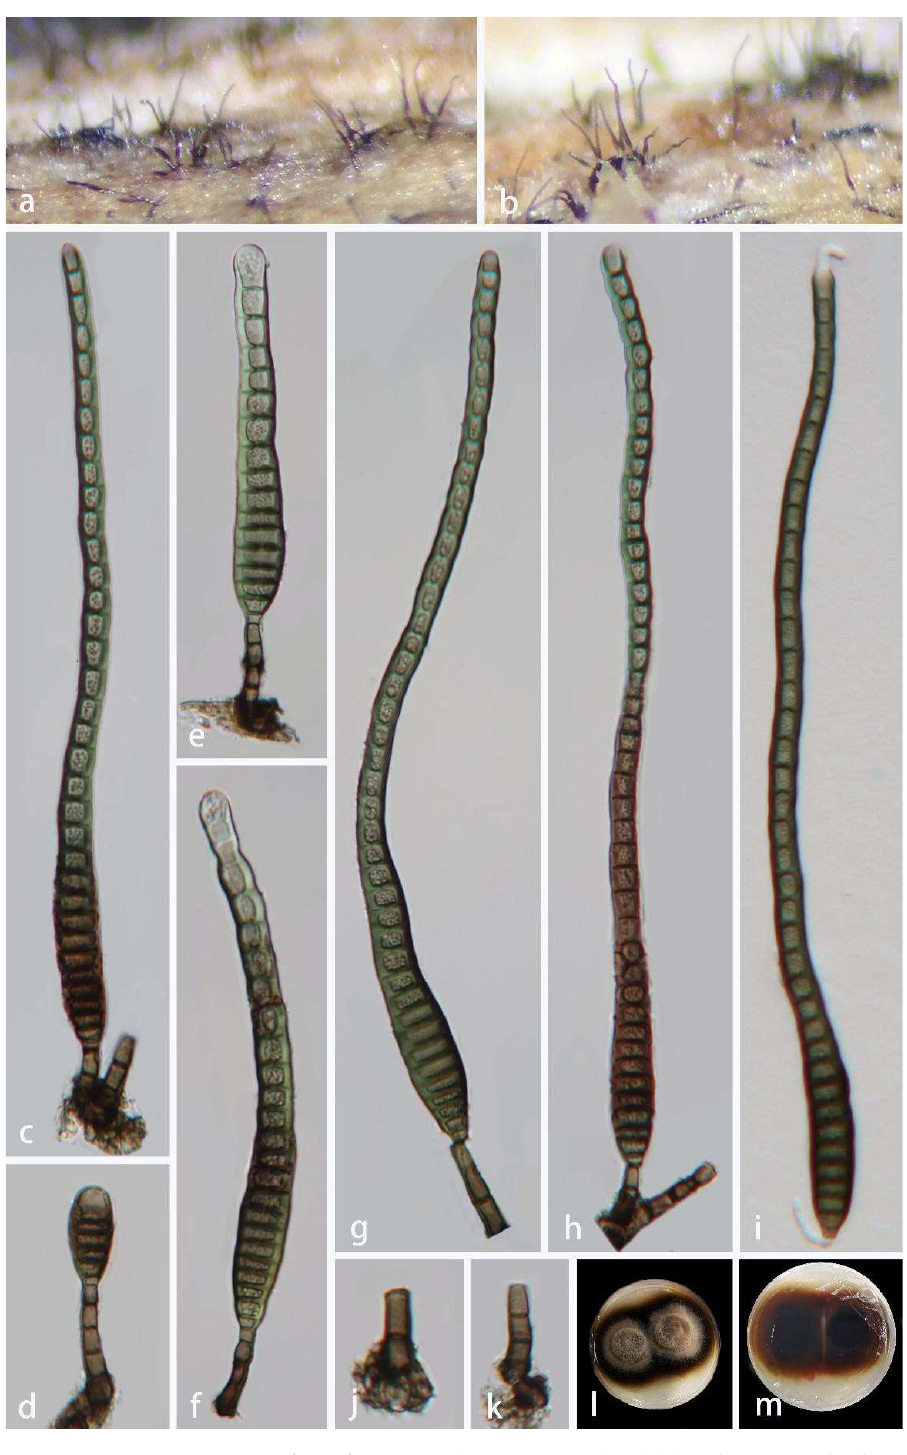
Figure 9. Distoseptispora xishuangbannaensis (HKAS 123760). ( a , b ) Colonies on the host surface. ( c – h ) Conidiophores, conidiogenous cells with attached conidia. (i) Germinating conidium. ( j , k ) Conidiophores and conidiogenous cells. ( l , m ) Colonies on PDA, l from above, m from below. Scale bars: ( c , k , e – i ) 20 μm, ( d , j ) 10 μm.